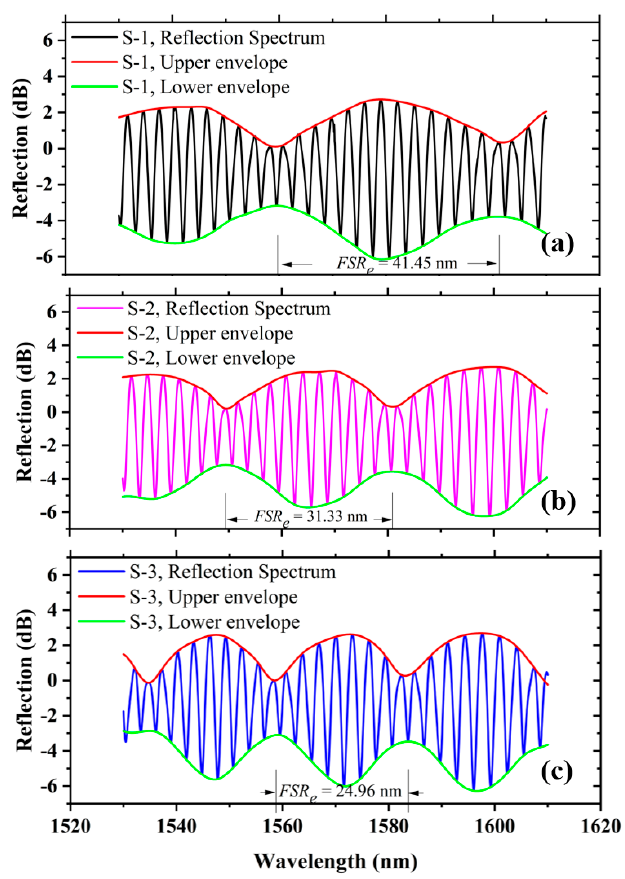
Figure 8. FSR e of cascaded FPIs ( a ) S-1, ( b ) S-2, ( c ) S-3. The axial strain response of S-1 is measured by using the experimental setup as shown in Figure 6. The spectral evolution of S-1 is recorded by applying stress, which causes axial strain from 0 με to 2600 με , with an axial strain step of 200 με . The envelope dip produces a red-shift (the change in wavelength toward a longer wavelength) in the spectra corresponding to increasing axial strain. The wavelength versus envelope data of S-1 is plotted in Figure 9. It can be seen that, by using VE, S-1 strain sensitivity is 23.9 pm/ με , which is almost 14 times higher than that of a single sensing FPI. The S-1 meas- urement also provides an excellent linear fit correlation function with R 2 = 0.99751. The measured strain values match well with theoretical analysis, and a small error is observed, which is induced by equipment measurement error, as provided in Table 1. Further, in order to realize the amplification factor of the proposed sensor, different cavity lengths in the cascaded FPIs are tested, i.e., S-2 and S-3. Air cavities for the reference FPIs are formed using a tunable cavity platform, where the cavity lengths for S-2 and S-3 are 365 μ m and 355 μ m, respectively. The FSR of the individual reference FPIs for S-2 and S-3 is measured as 3.28 nm and 3.36 nm, respectively. The spectral evolution is presented in the inset of Figure 10. S-2 exhibits axial strain sensitivity of 17.54 pm/ με , with an excellent linear cor- relation function of R 2 = 0.99905 in the strain measurement range of 0 με to 3000 με , and produces a red-shift with increasing axial strain, as shown in Figure 10. The strain sensi- tivity of S-2 is 10 times higher than that of the single sensing FPI. Finally, S-3 was tested to measure its response to axial strain. As with S-1 and S-2, S-3 also produced a red-shift in the spectral evolution with increasing axial strain. The plot of S-3-exhibited wavelength versus dip variation due to axial strain is shown in Figure 11. S-3 exhibits axial strain sen- sitivity of 14.11 pm/ με , which is 7.98 times higher than the single sensing FPI, and shows an excellent linear correlation function of R 2 = 0.99901 in the strain measurement range of 0 με to 3000 με , as shown in Figure 11.